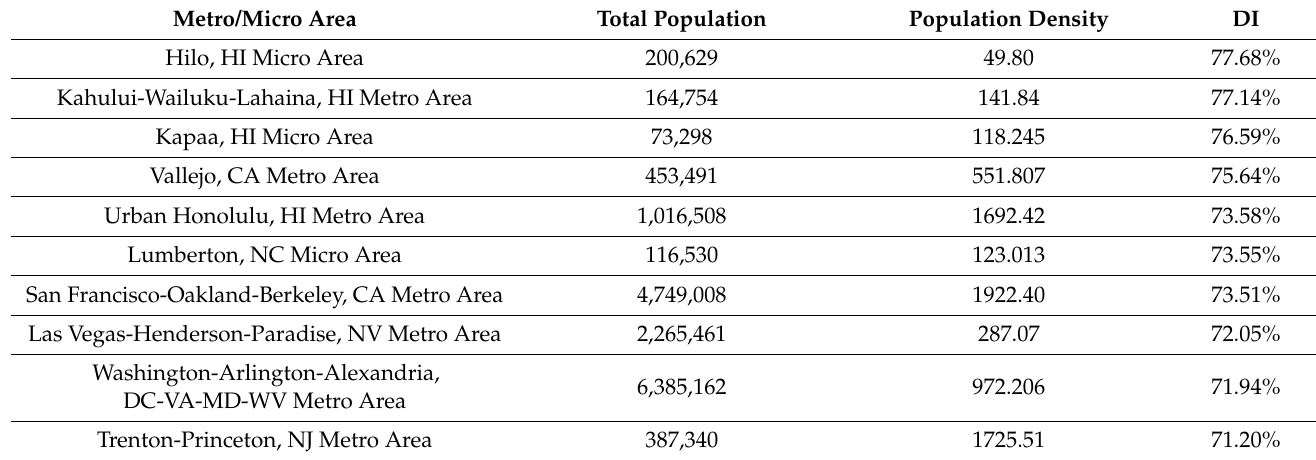
Table 1. Diversity Index: Ten Highest Metro/Micro Areas, 2020.